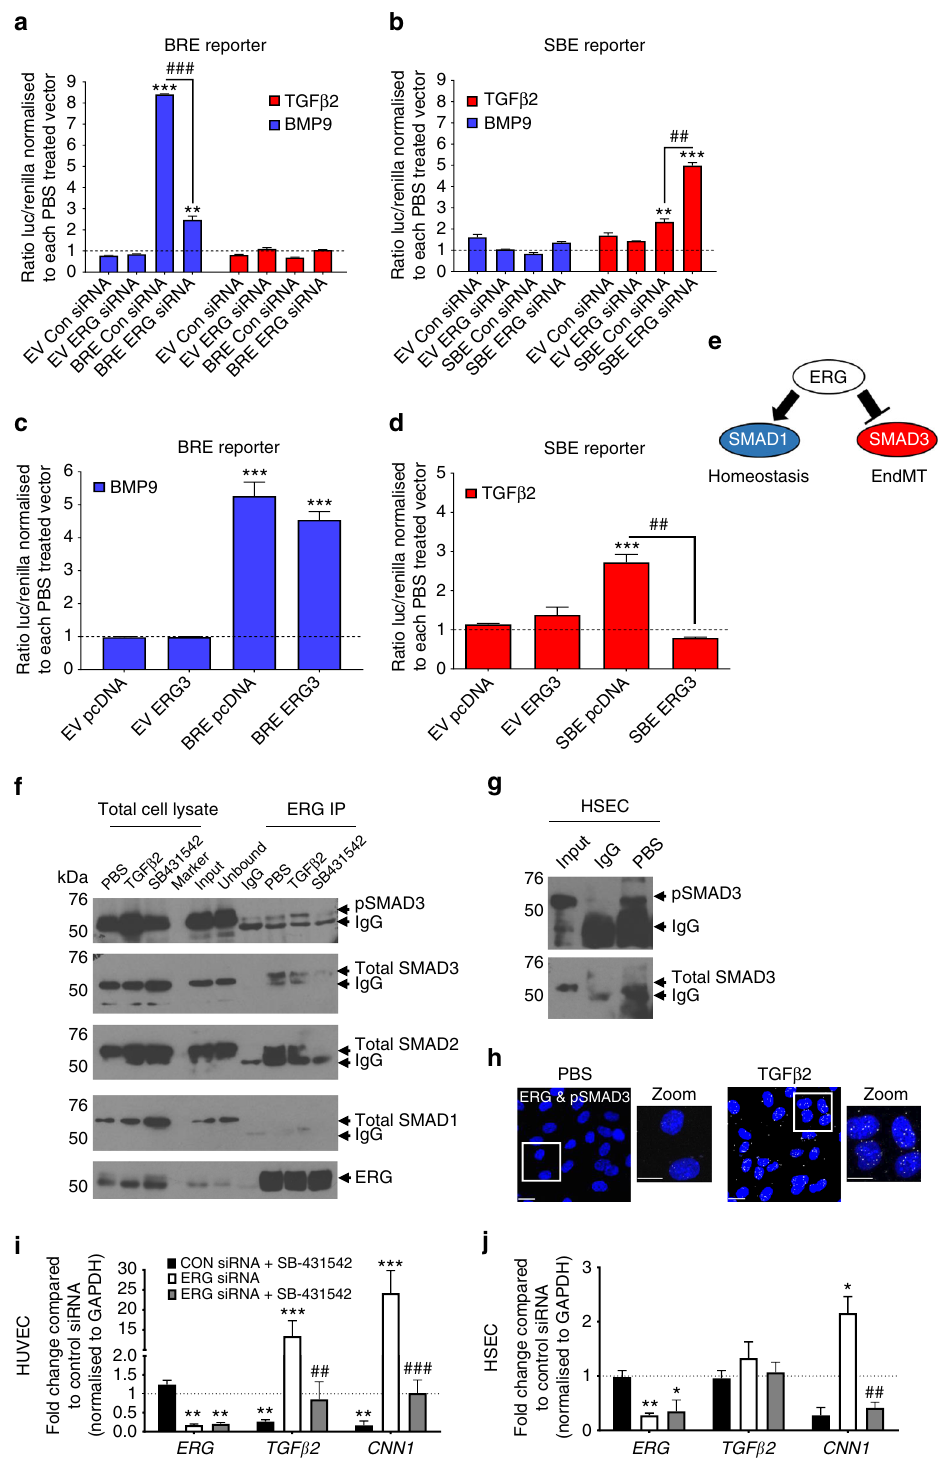
reduced CCL 4 -induced SMA expression (Fig. 6f), normalised endothelial ERG expression (Fig. 6g) and reduced phosphoryla- tion of SMAD3 (Fig. 6h and Supplementary Fig. 9C). However, etanercept was unable to correct the CCL4-induced injury in Erg cEC-het mice (Fig. 6i), with no normalisation of transcriptional target genes (Fig. 6j) or SMA expression in the liver (Fig. 6k).